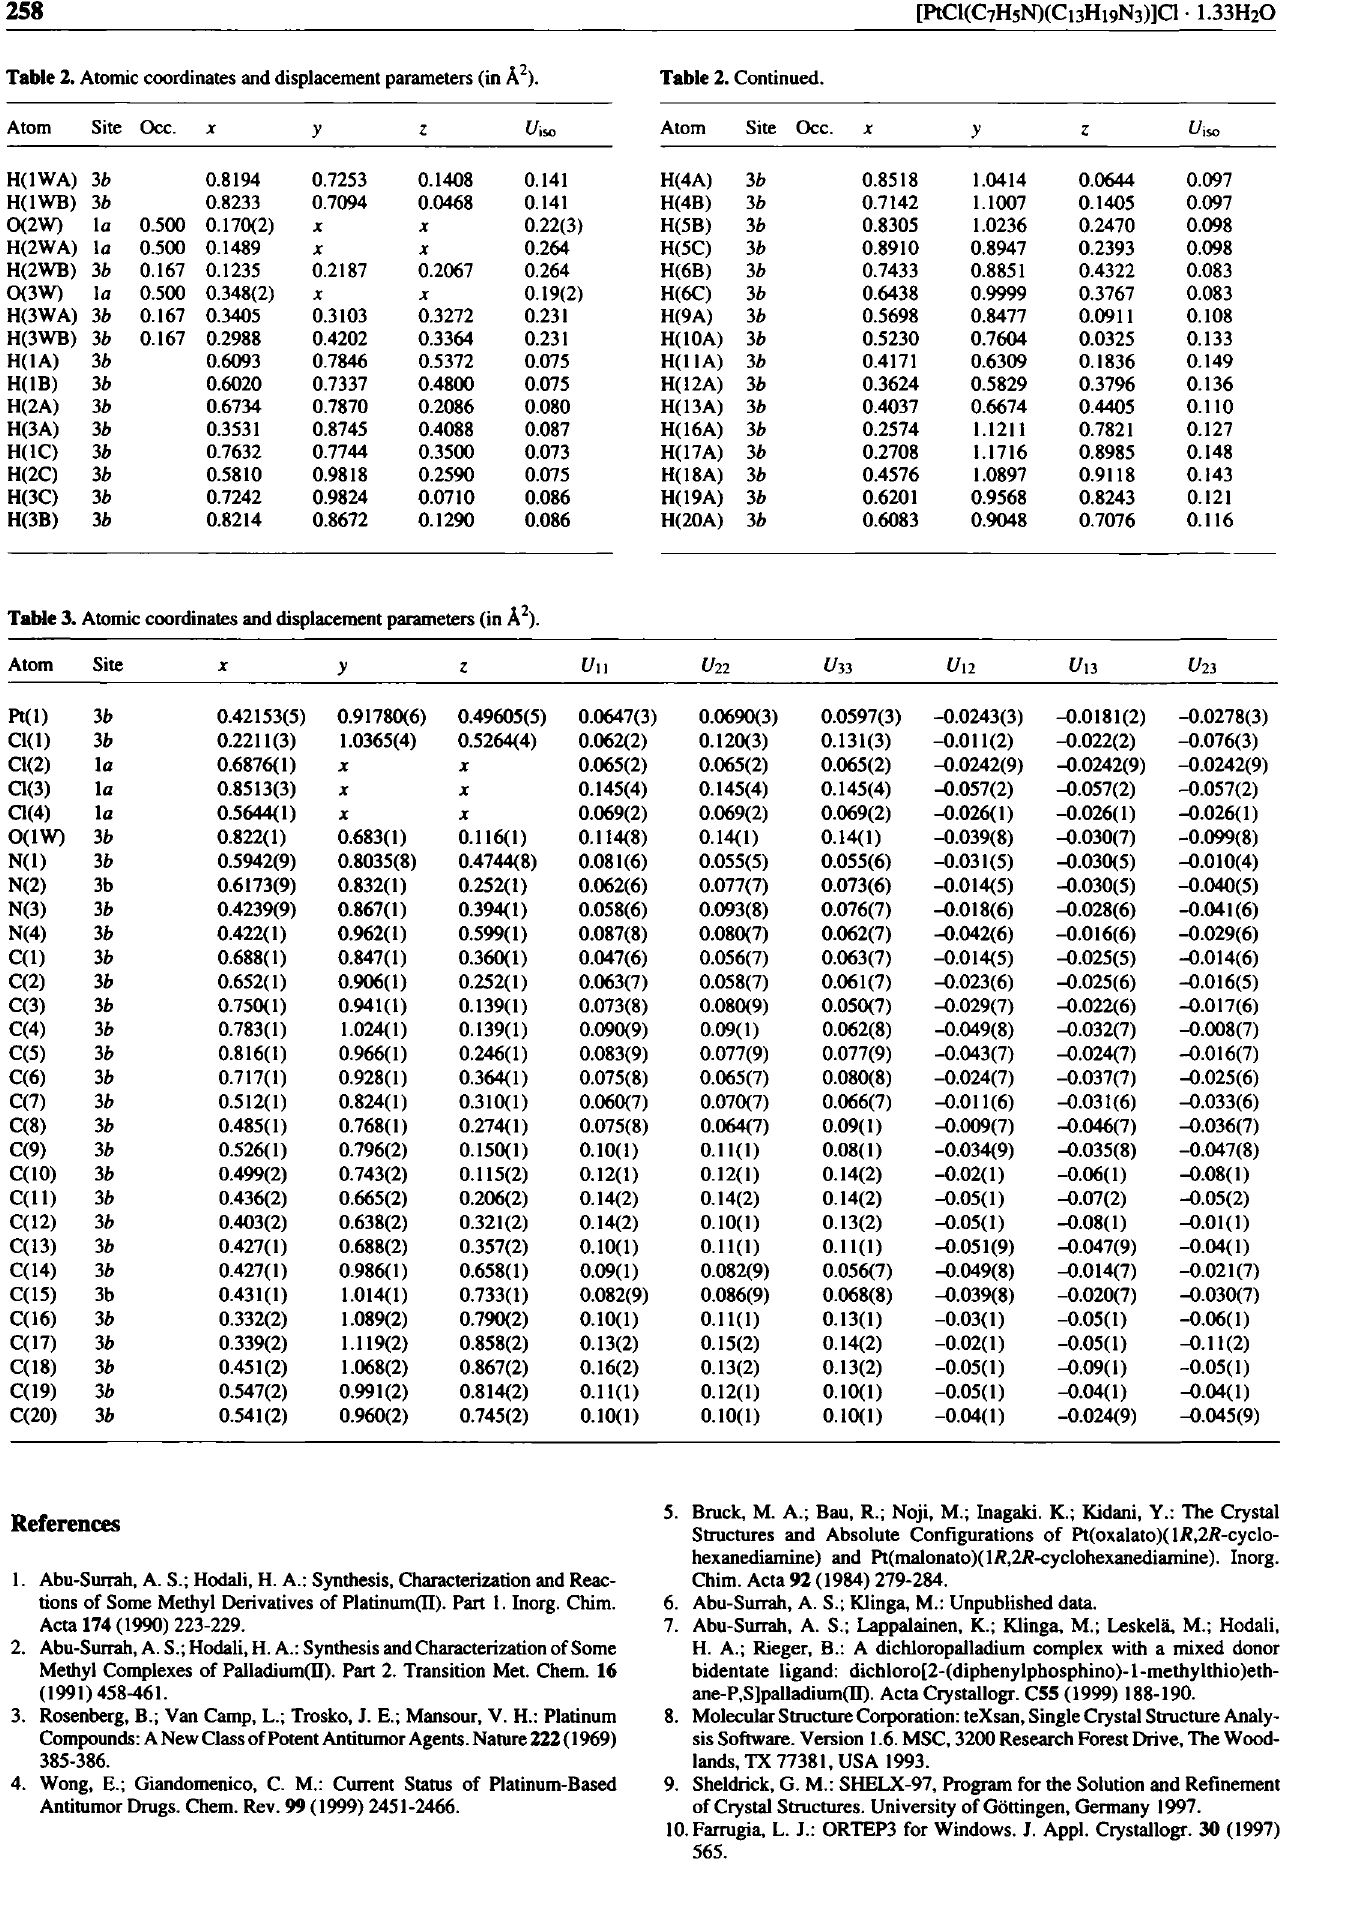
Table 2. Atomic coordinates and displacement parameters (in Â 2 ).